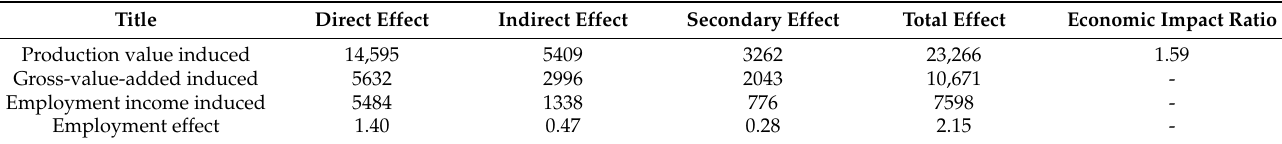
Table 5. The economic impact (measured in thousands of yen or in people) of the construction of a concrete dam, after unifying the amount of sediment-runoff